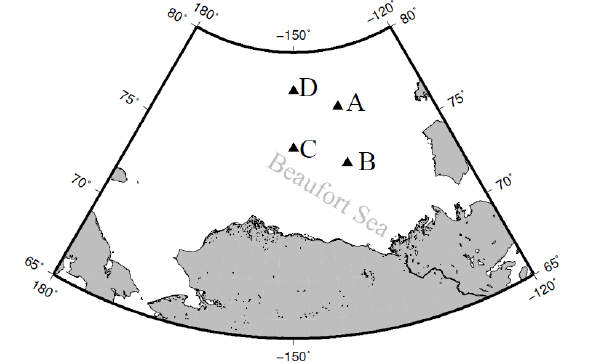
Figure 1. Locations of the four ULSs of the Beaufort Gyre Exploration Project